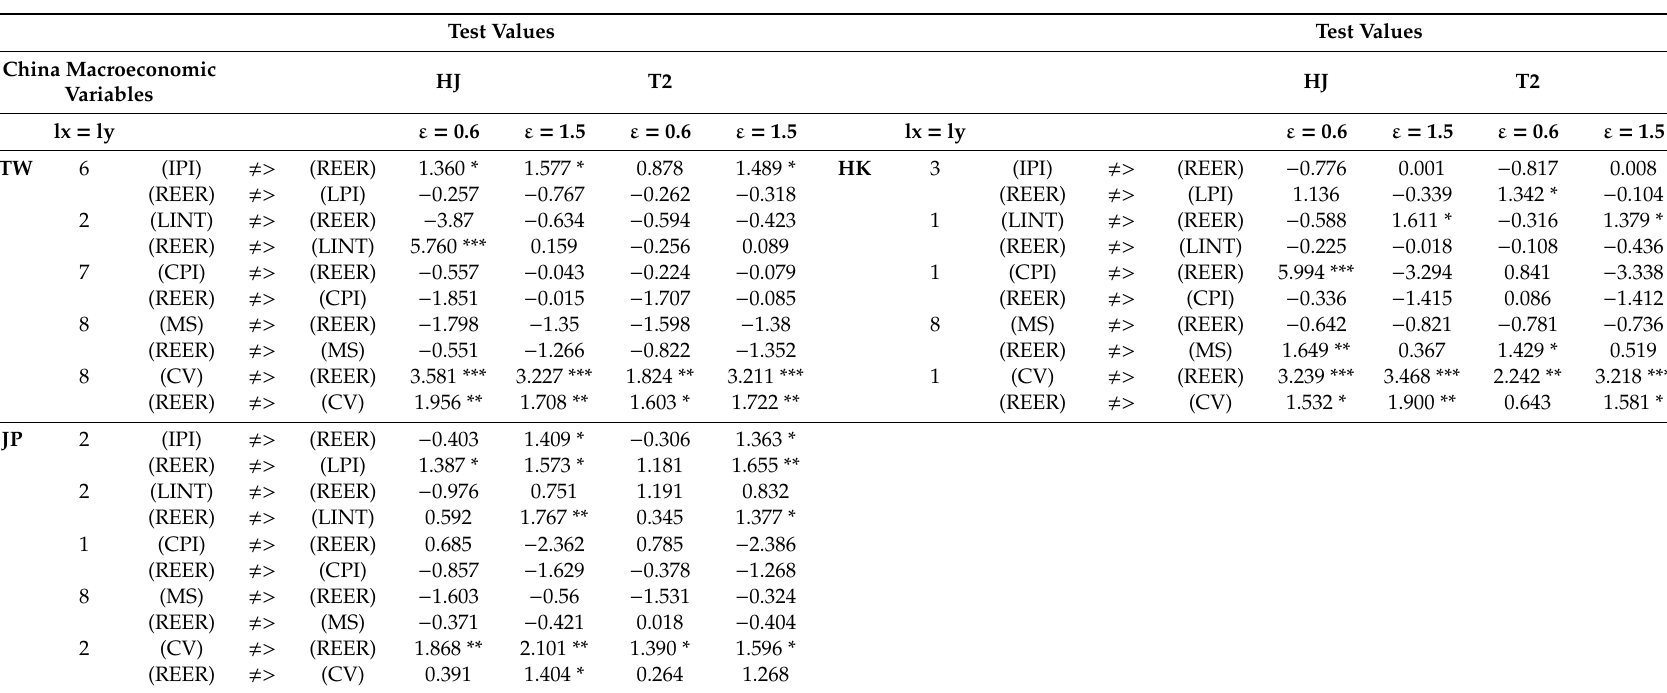
Table 12. Non-linear causality test between REERs and the China macroeconomic variables: January 1998–April 2017. Test Values Test